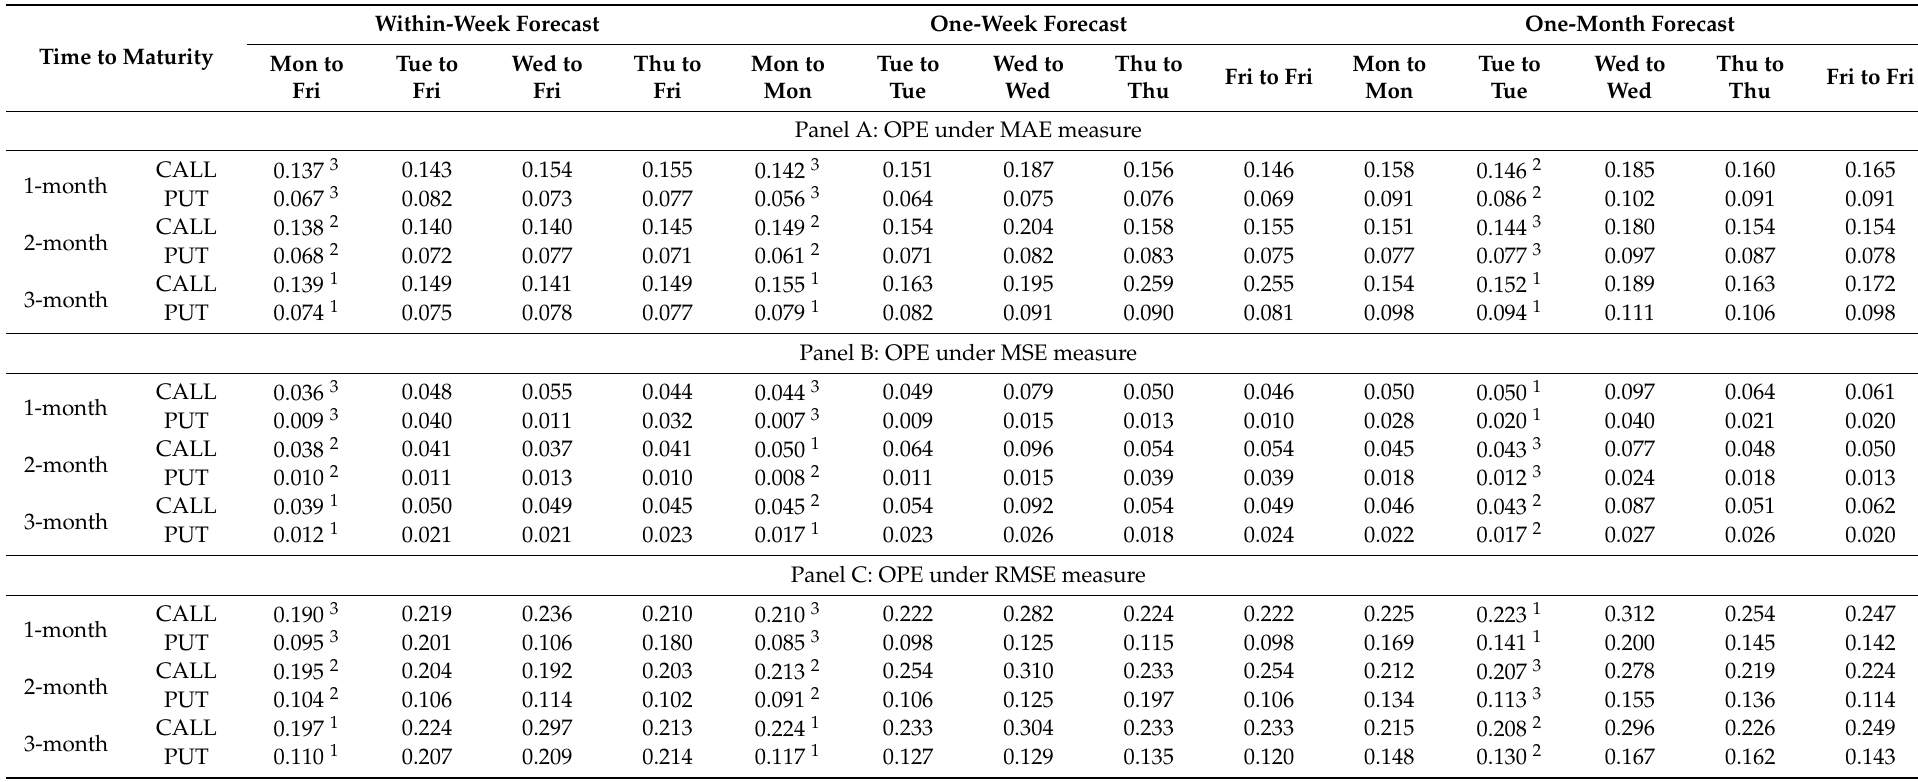
Table 2. Estimate options pricing error for AUD options for the within-week, one-week, and one-month